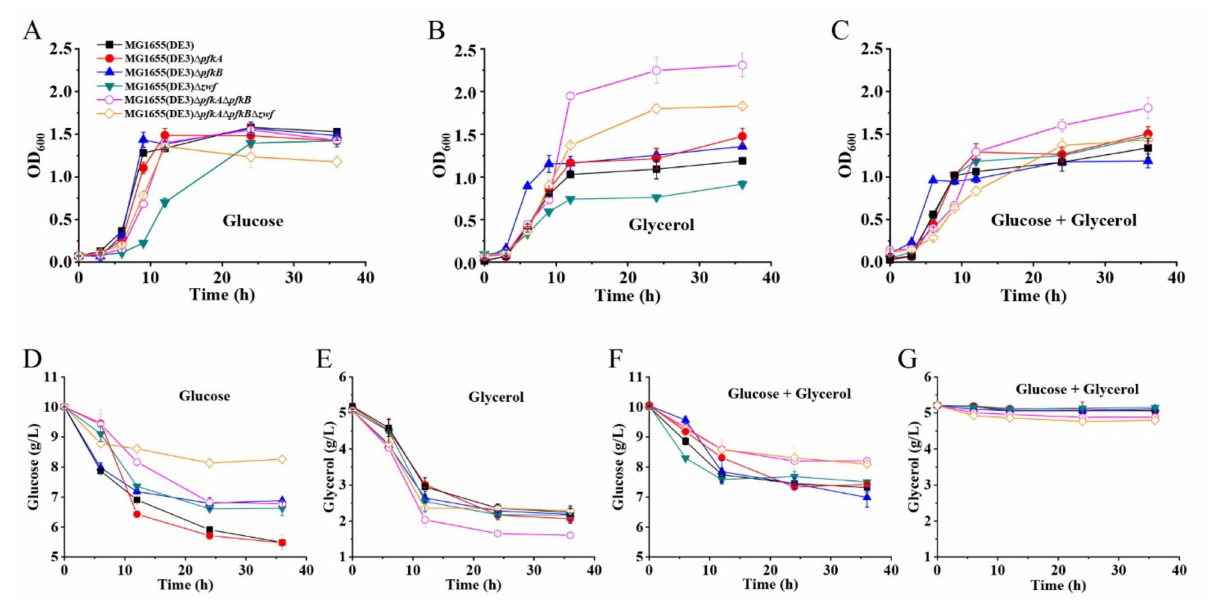
Figure 2. Characterization of mutants MG1655(DE3) ∆ pfkA , MG1655(DE3) ∆ pfkB , MG1655(DE3) ∆ zwf , MG1655(DE3) ∆ pfkA ∆ pfkB and MG1655(DE3) ∆ pfkA ∆ pfkB ∆ zwf . Growth profiles of various strains cul- tivated in ( A ) M9s+glucose medium, ( B ) M9s+glycerol medium, ( C ) M9s+glucose+glycerol medium; ( D ) glucose consumption of various strains cultivated in M9s+glucose medium; ( E ) glycerol con- sumption of various strains cultivated in M9s+glycerol medium; ( F ) glucose consumption of various strains cultivated in M9s+glucose+glycerol medium; ( G ) glycerol consumption of various strains cultivated in M9s+glucose+glycerol medium. Mean values are based on three independent